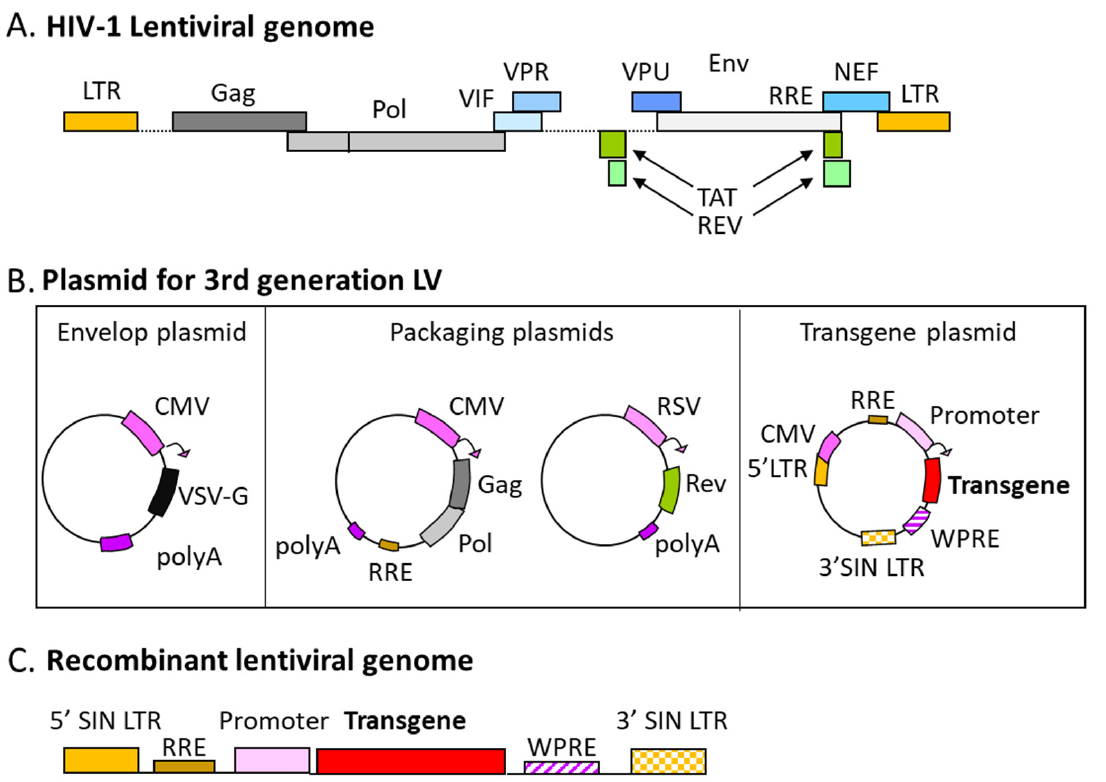
Figure 2. From lentivirus to 3rd generation lentiviral vector system. ( A ) Schematic representation of the natural HIV-1 genome. Structural and enzymatic HIV-1 genes are presented in gray boxes, HIV-1 regulatory factors in green, HIV-1 accessory factors in blue, and LTR in yellow. ( B ) Composition of the 4 plasmids co-transfected to generate LV; the envelope plasmid, the 2 packaging plasmids (expression of viral proteins), and the transgene plasmid (therapeutic cassette). Regulatory sequences used in the different plasmids generated for recombinant lentiviral production are in pink boxes, and the transgene in a red box. The curved arrow represents the start site of transcription. ( C ) Final genome of the recombinant lentiviral vector integrated into the host cell.